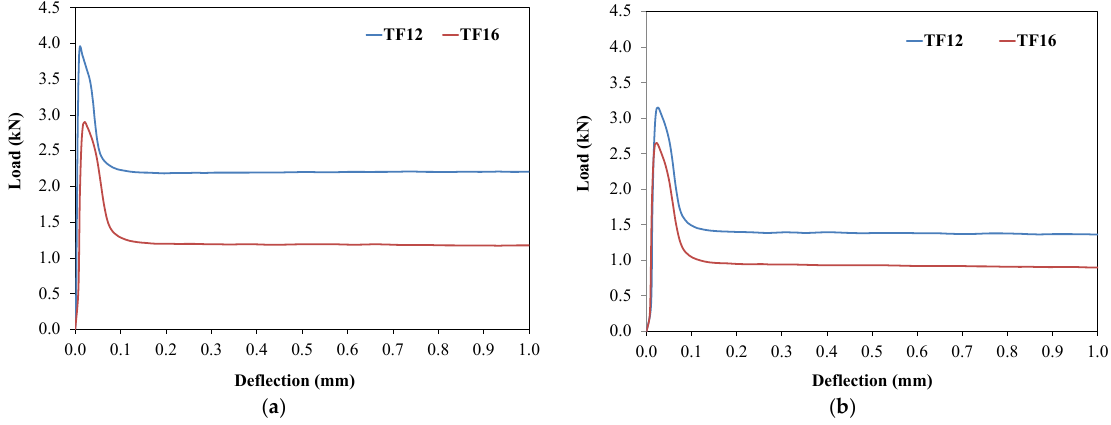
Figure 14. Load ‐ deflection behavior of plain weave fabric ( a ) warp ( b ) weft.